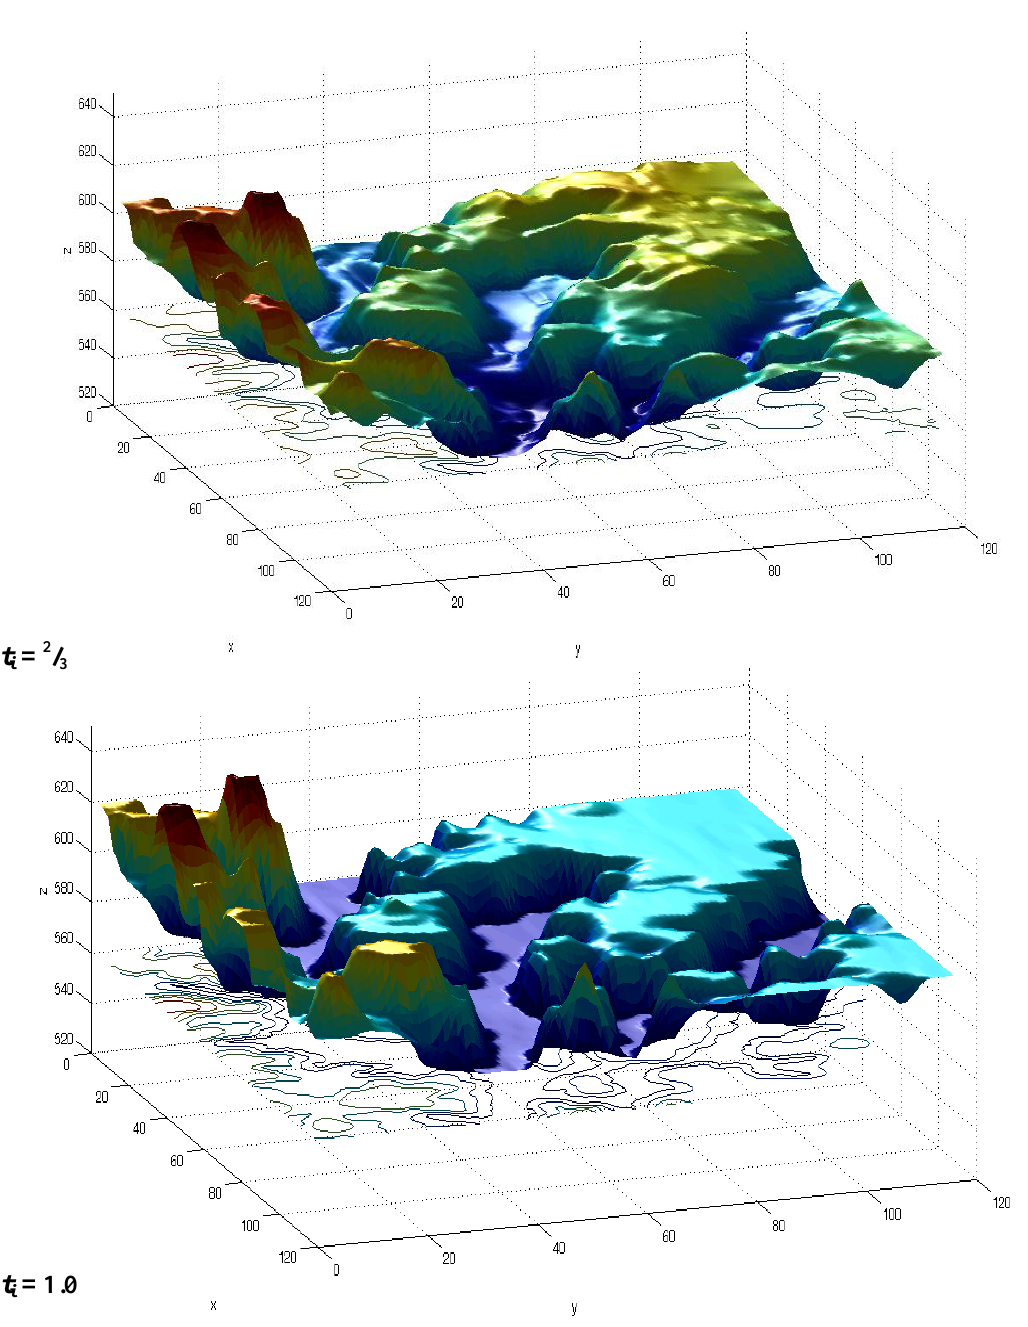
Figure 15. Intermediate scene t ( t = 0.0, Figure 13 top row) and target topographic datasets ( t 0 DTPM (figures are with no scale, z -axis in